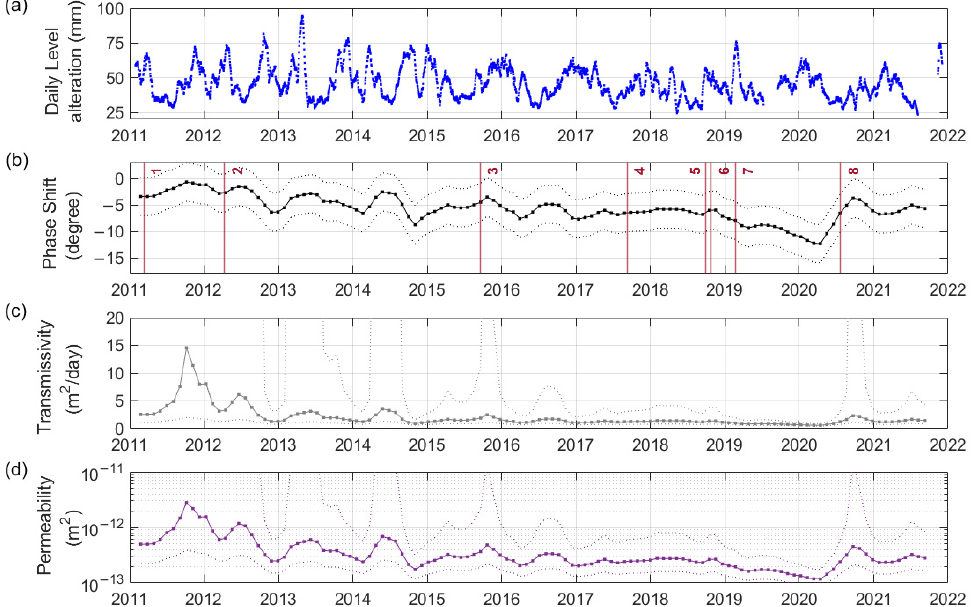
Figure 5. Diagrams of the daily level alteration ( a ), phase shift ( b ), transmissivity ( c ), permeability ( d ). Red numbers in ( b ) correspond to the earthquakes: 1—11 March 2011 Tohoku, Japan; 2—11